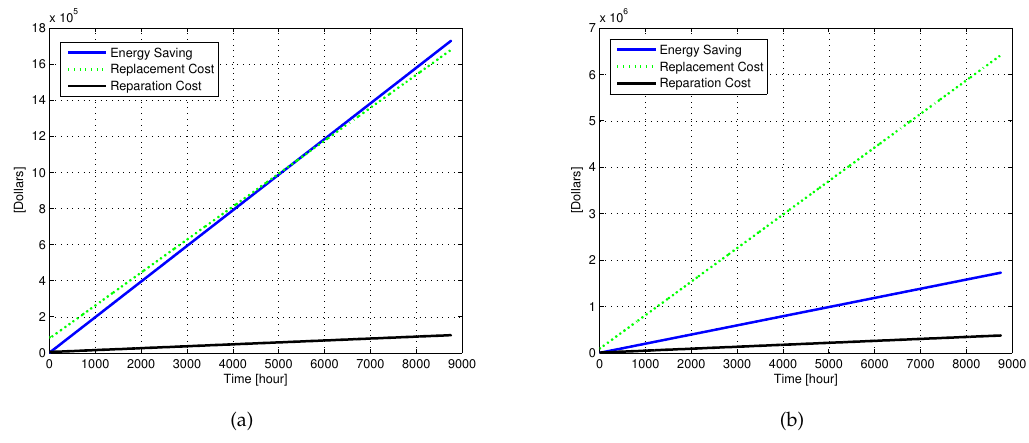
Figure 13. Cost Analysis for the UMTS scenario. ( a ) AF off = 0.2, χ off χ off = 2 ref